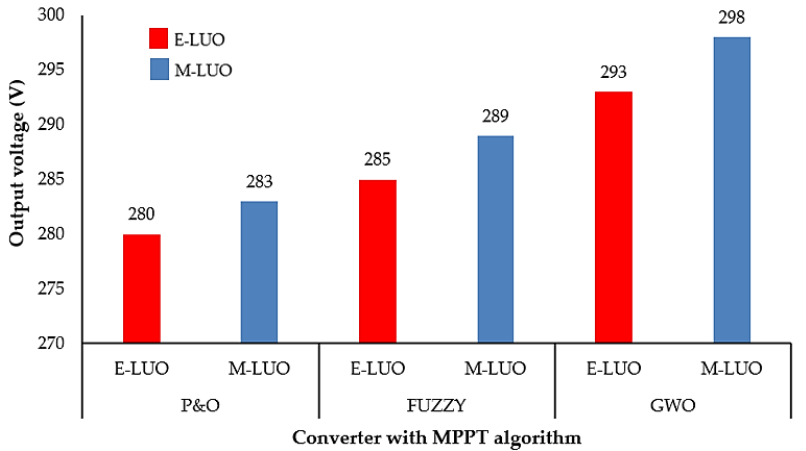
Figure 13. Output voltage comparison of different MPPT methods for the elementary and modified LUO converters (E-LUO and M-LUO).